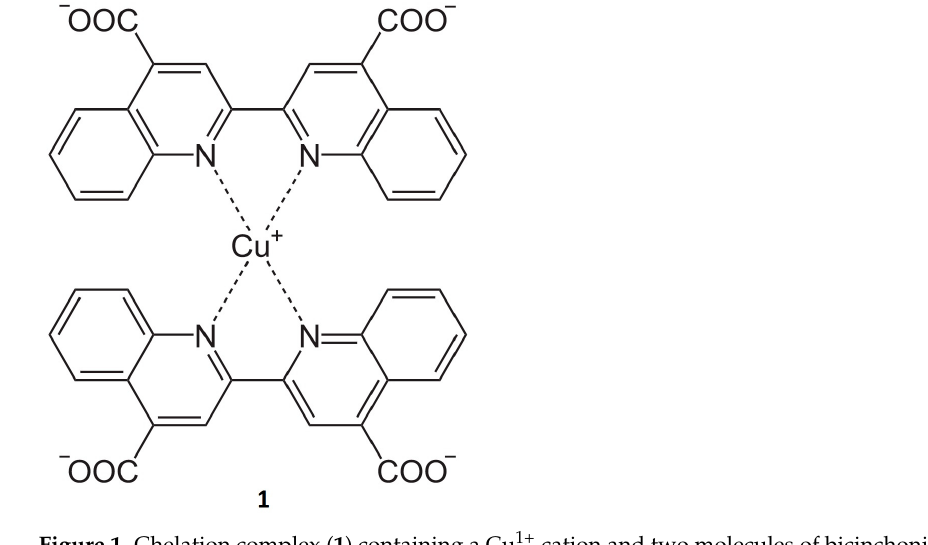
Figure 1. Chelation complex ( 1 ) containing a Cu 1+ cation and two molecules of bicinchoninic acid. Given the described findings, the aim of this study was to determine the extent of contamination of dental instruments after their application by testing spray-water sample protein concentrations using